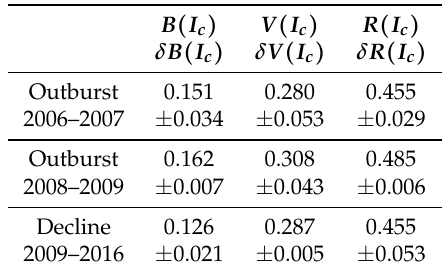
Table 3. The inclination angles for photometric data.